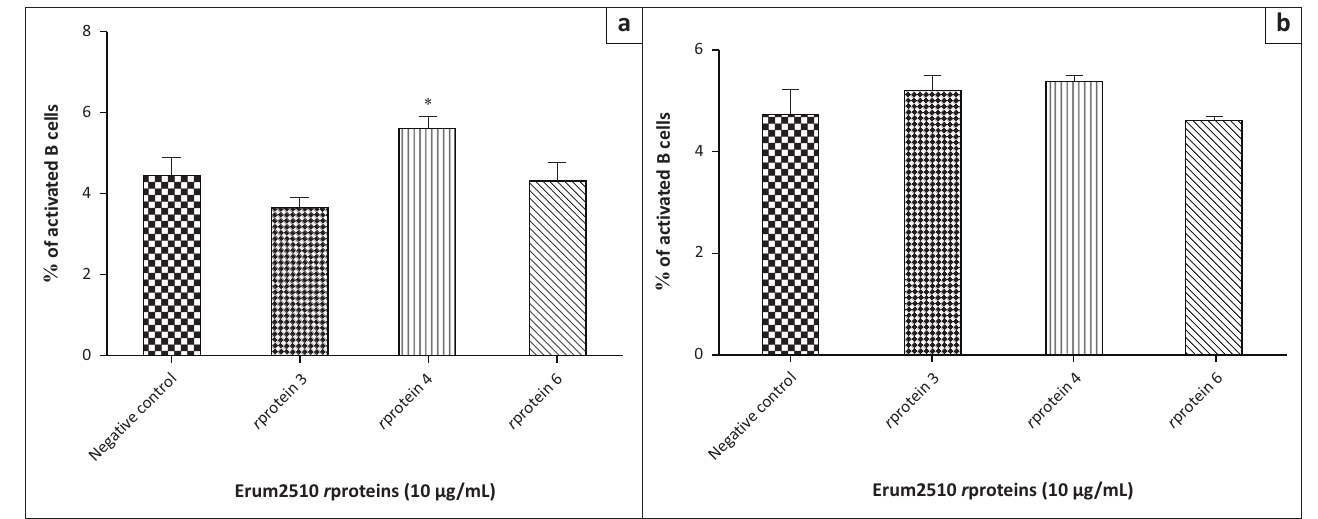
Erum2510 r proteins (10